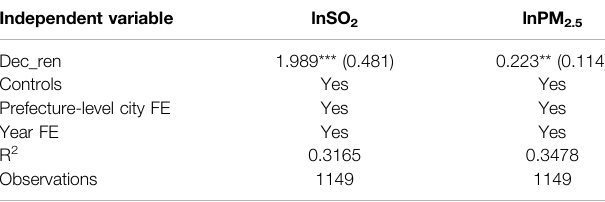
TABLE 4 | Robustness